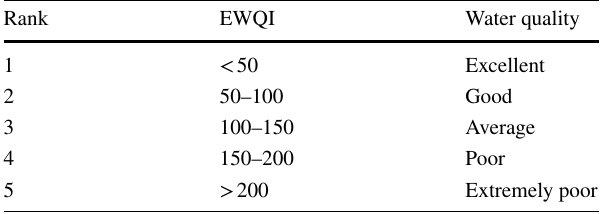
Table 2 Water quality scale for EWQI (Wu et al.